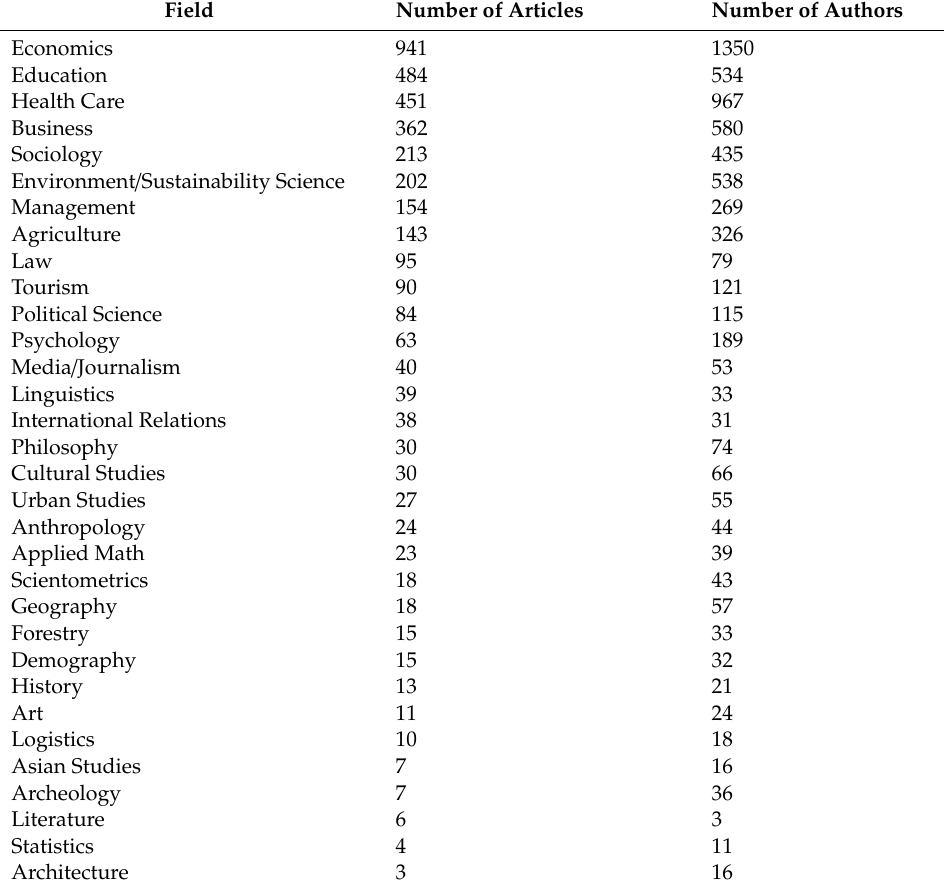
Table 1. Disciplines in Social Sciences and Humanities (SSH) in Vietnam (2008–2019). Field Number of